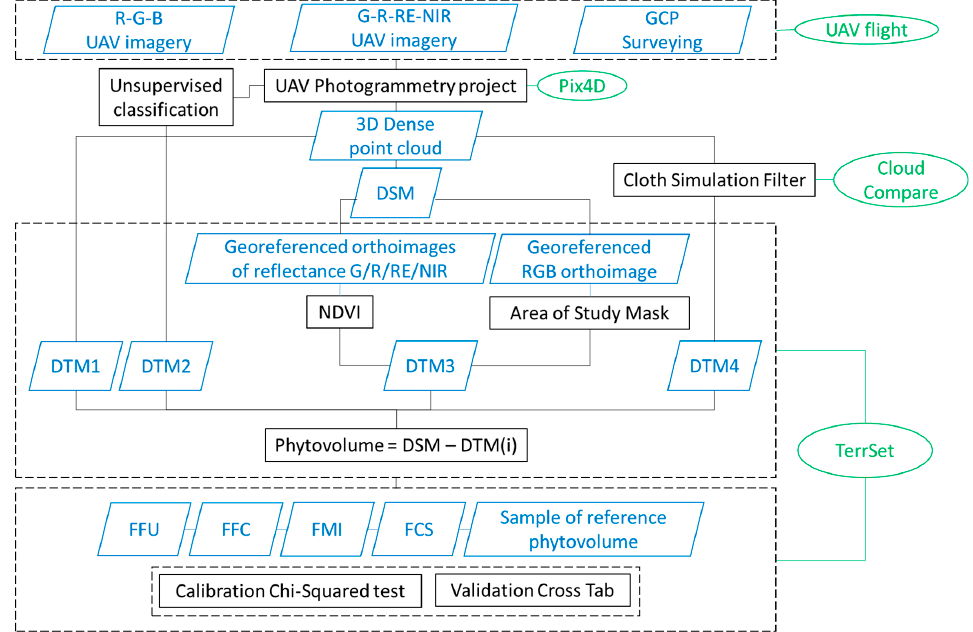
Figure 6. Flowchart of the applied methodology. Digital terrain models (DTMs) numbered from one to four were used to obtain the FFU, FFC, FMI, and FCS estimators, respectively.